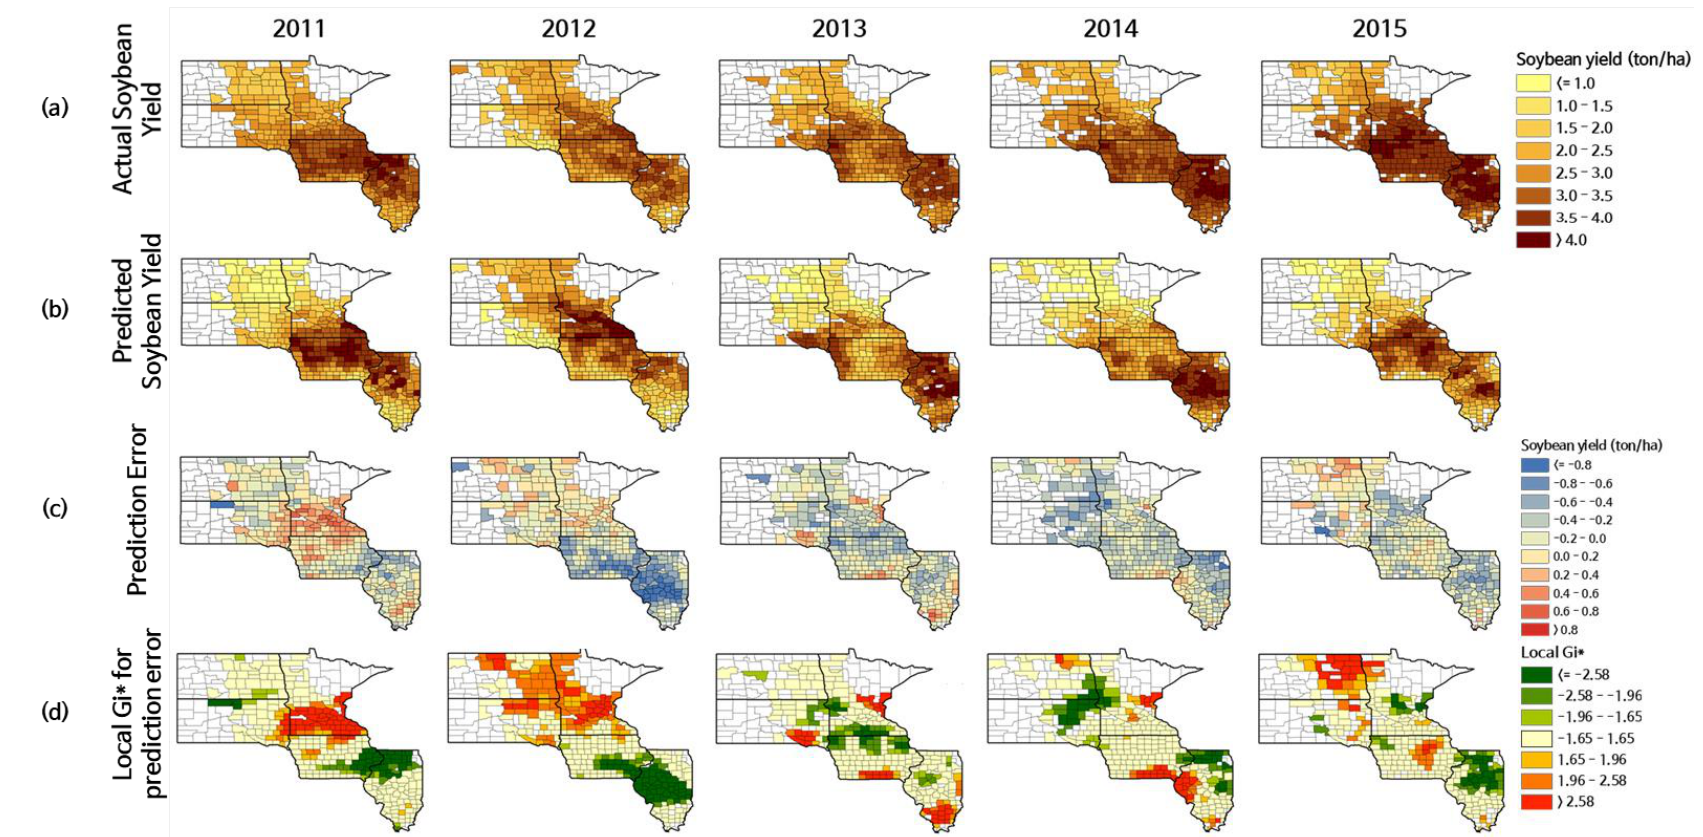
Figure 10. Maps of the actual and predicted soybean yields, prediction errors, and Local Geary index (Gi*) of the prediction errors, 2011 – 2015.